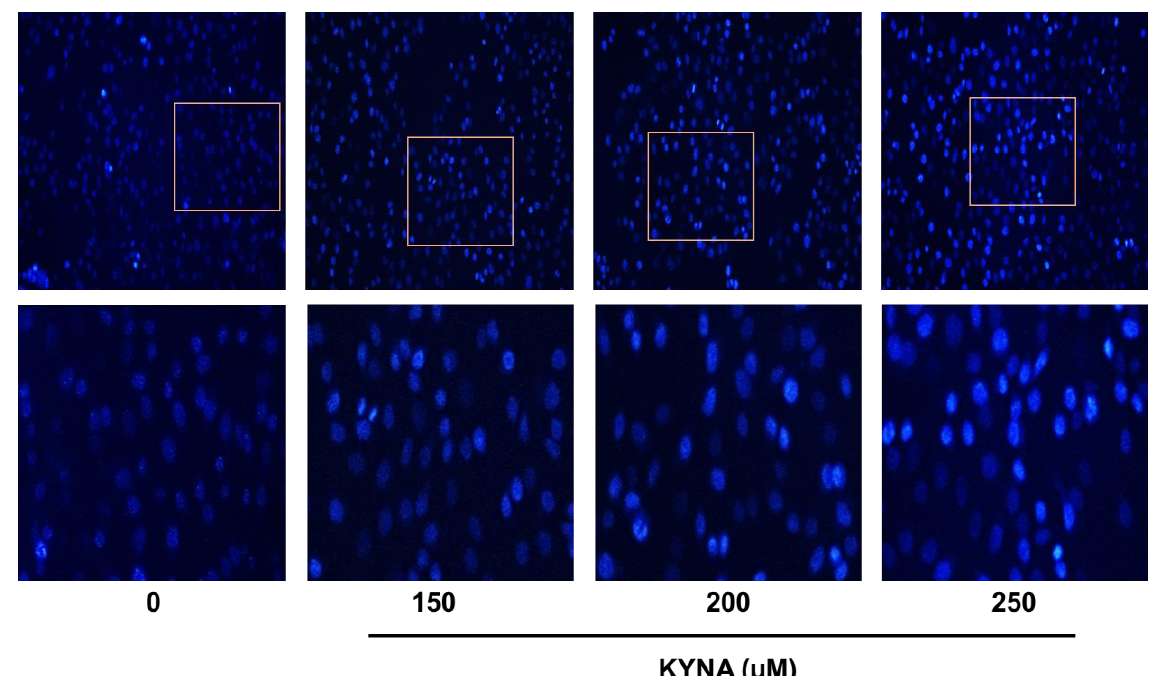
Figure 7. Nuclear morphological changes on KYNA treated AGS cells. AGS cells were treated with KYNA at indicated concentrations (150, 200, and 250 µ M) for 24 h. After fixation, the cells were stained with 40-6-diamidino-2-phenylindole (DAPI) to observe fragmented chromatin and apoptotic bodies.